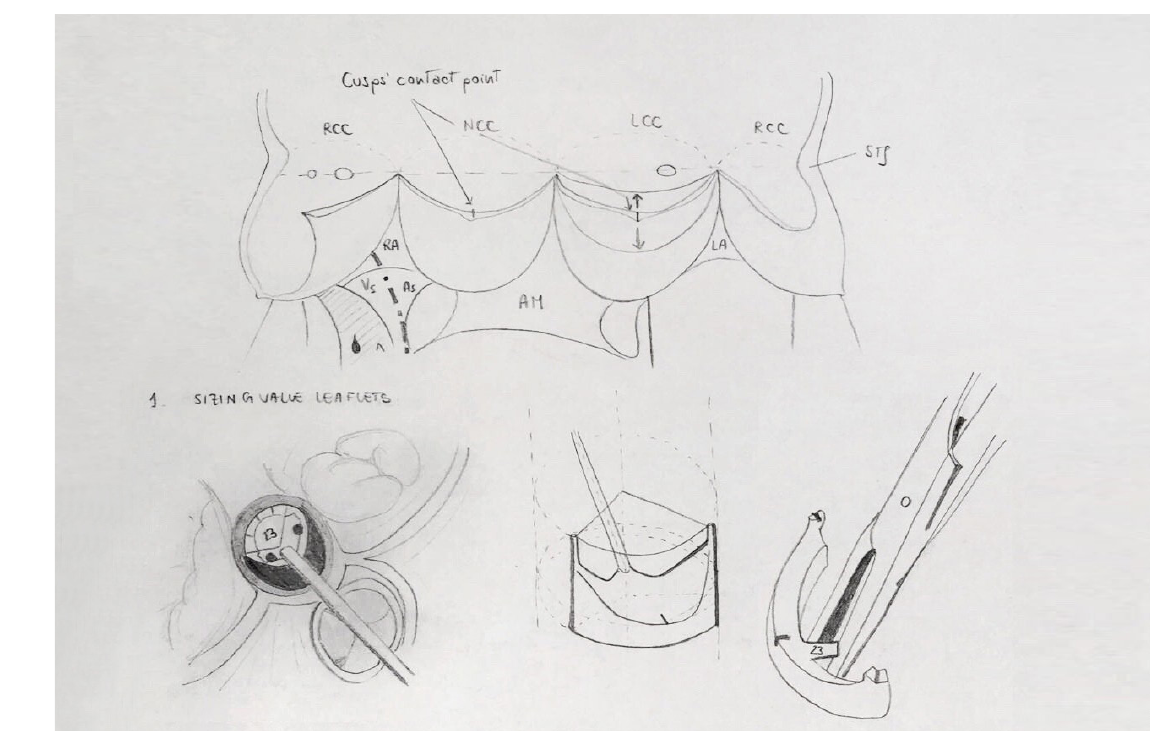
Fig. 2 - Pericardial template.